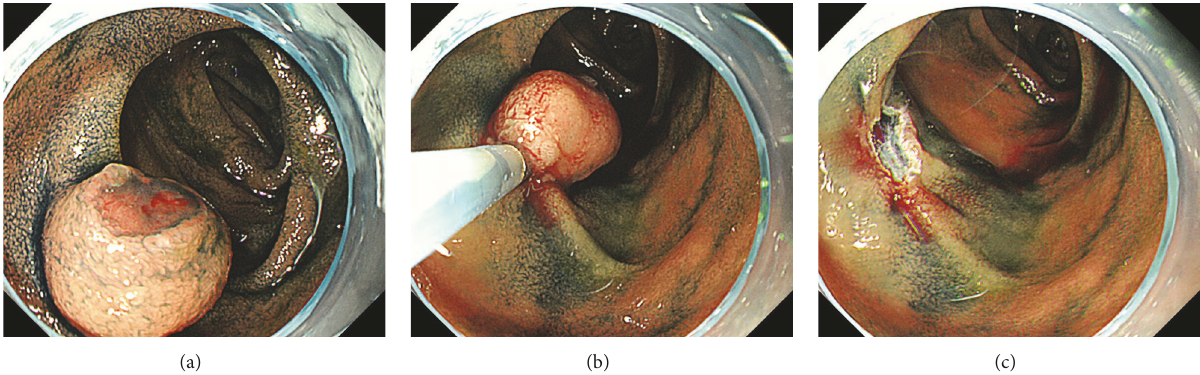
Figure 3: Esophagogastroduodenoscopy images during endoscopic mucosal resection. A duodenal tumor is seen after indigo carmine spraying (a). After injection of hyaluronic acid solution into the duodenal submucosa, the tumor is completely resected with a bipolar snare (b, c).